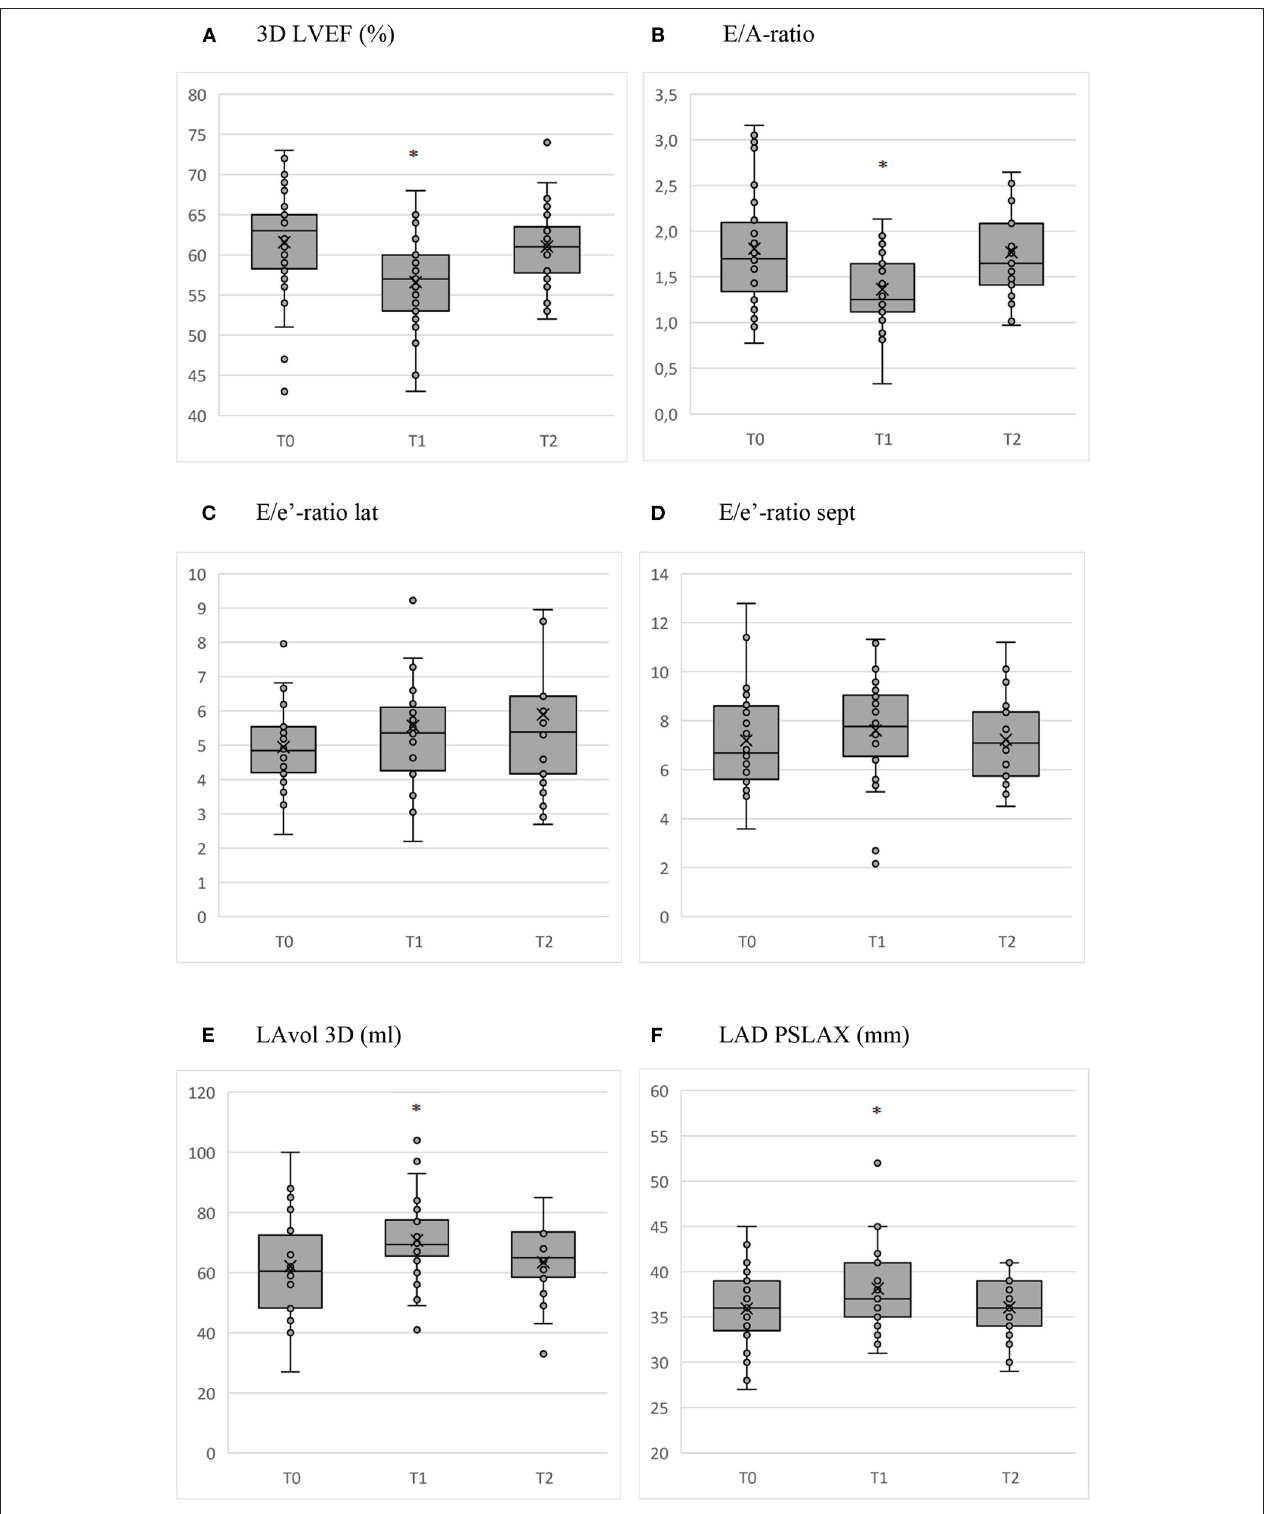
FIGURE 1 | Box and whisker plots of the relevant parameters measured with echocardiography before (T 0 ) and at the end of the cycle (T 1 ) with AAS, and after the recovery period (T 2 ). * P < 0.01. (A) 3D LVEF (%). (B) E/A-ratio. (C) E/e’-ratio lat. (D) E/e’-ratio sept. (E) LAvol 3D (ml). (F) LAD PSLAX